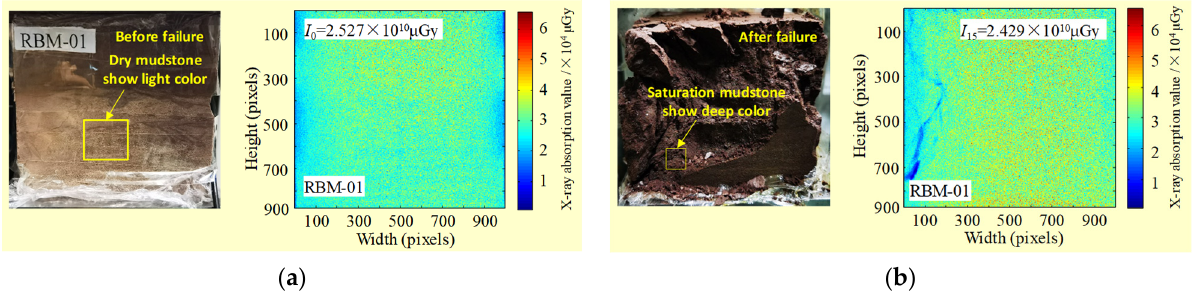
Figure 6. Image interpretations on red-bed mudstone color characteristics and X-ray absorbed dose in nondestructive and hydro-damage states. ( a ) Color features and image analysis of mudstone surface in nondestructive state. ( b ) Color features and image analysis of mudstone indication in the hydro-damage state. Table 3. Statistical Results of the Multilevel Stress Peak and Hydro-Damage Coefficient During Red-Bed Mudstone Specimen